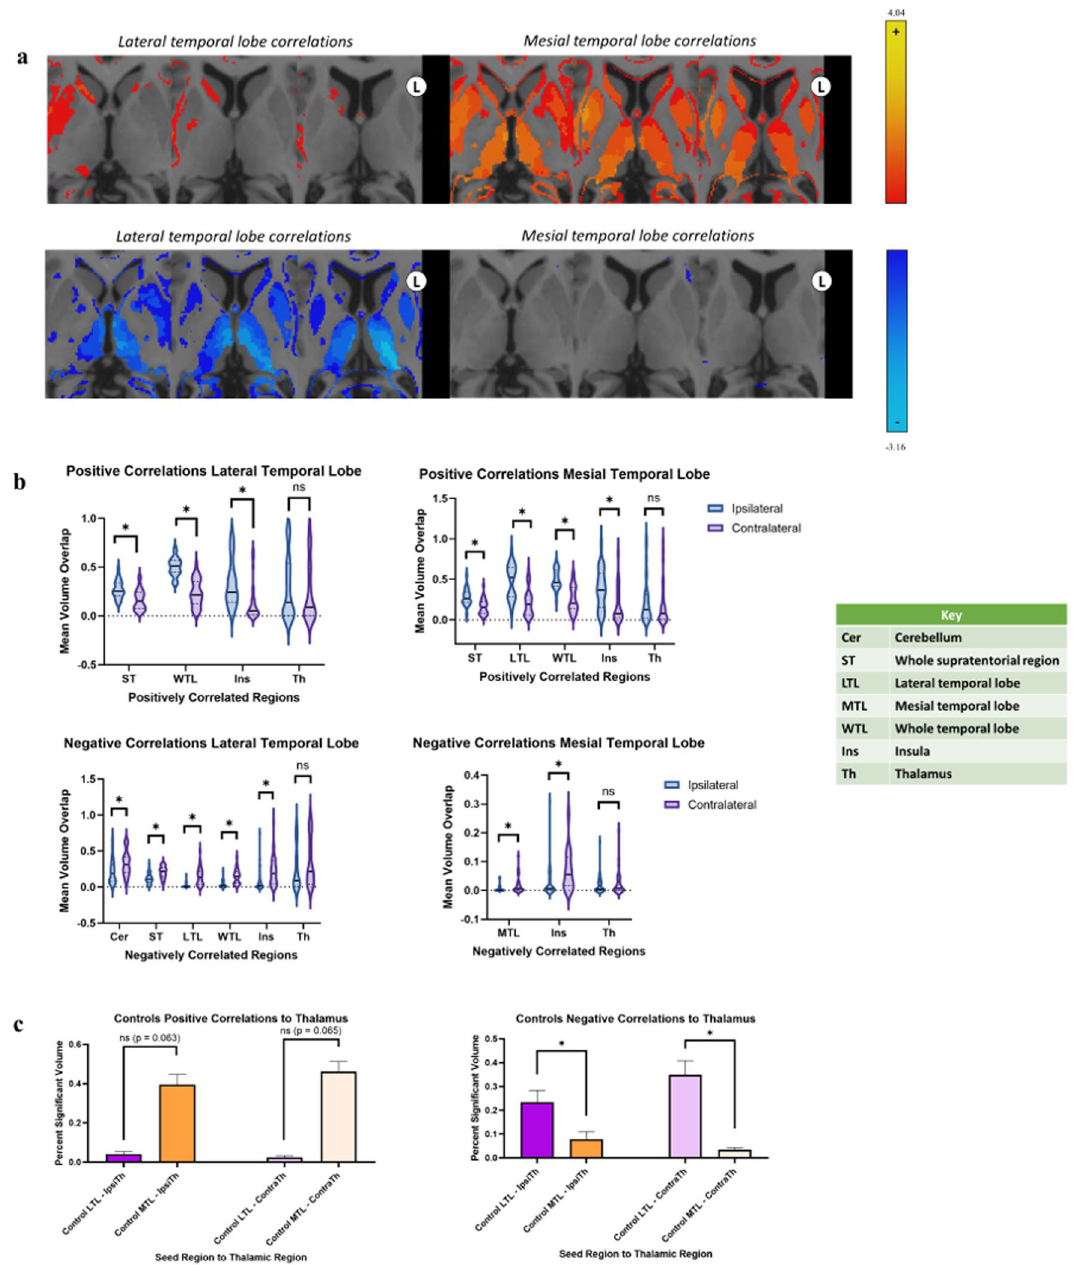
Figure 2. Positive and negative temporal lobe connectivity in healthy controls. ( a ) Heatmaps of connectivity from the LTL (left) and MTL (right) to thalamic regions. ( b ) Comparisons of positive and negative connectivity between ipsilateral and contralateral connections with the seed as the LTL (left) and the MTL (right). ( c ) Comparisons of positive and negative connectivity between the LTL and Th and the MTL and Th. In all sections, regions with significant differences found at p < 0.05 are marked with *. Regions without significant differences are marked with “ns” for not significant. Images are displayed in radiographic orientation. Correlations shown are based on ipsilateral and contralateral correlations from the temporal lobe; as such, the right-side temporal lobe seed heatmaps were mirrored to combine with the left-side seed heatmaps for visualization purposes. The left and right sides of the images are marked with L and R; the side that was used as the seed is the one displayed on the